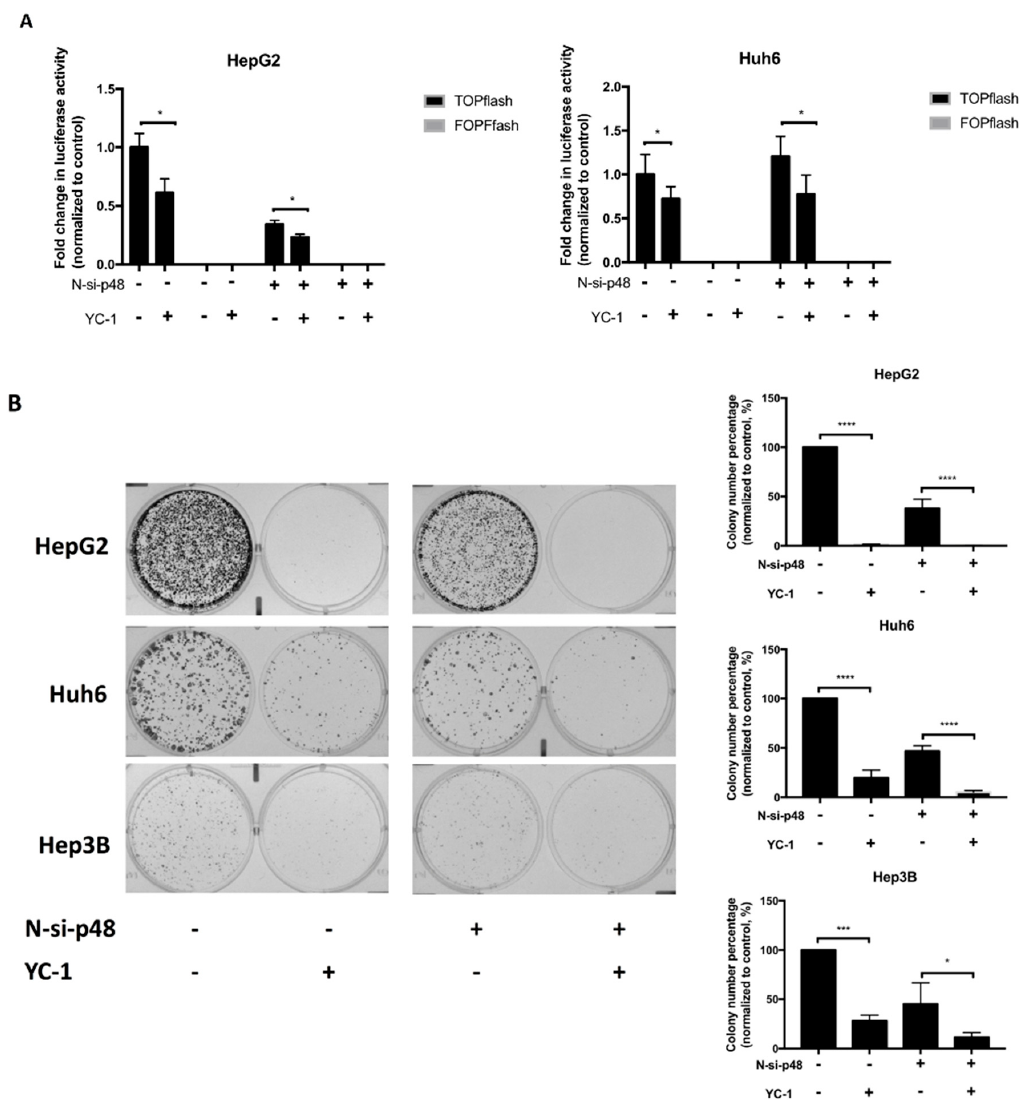
Figure 5. YC-1 inhibited colony formation through EBP1 p42, suppressing the Wnt/ β -catenin pathway in HCC cells. Scrambled and N-si-p48 DsiRNA were transfected into HepG2 and Huh6 cells along with either the TOPflash or FOPflash vector following the indicated treatments. These transfected cells were treated with the IC 50 of YC-1 for 6 hours, and luciferase activity was measured ( A ). Cells transfected with different DsiRNAs were seeded in 6-well plates at 5 × 10 4 cells per well and incubated for 48 hours. These cells were treated with the IC 50 of YC-1 for 24 hours, and the medium was then replaced with fresh medium. After one to two weeks, colonies were stained and counted. The error bars indicate the SEMs of data obtained in at least three independent experiments ( B ). * p < 0.05, *** p < 0.001, **** p < 0.0001.